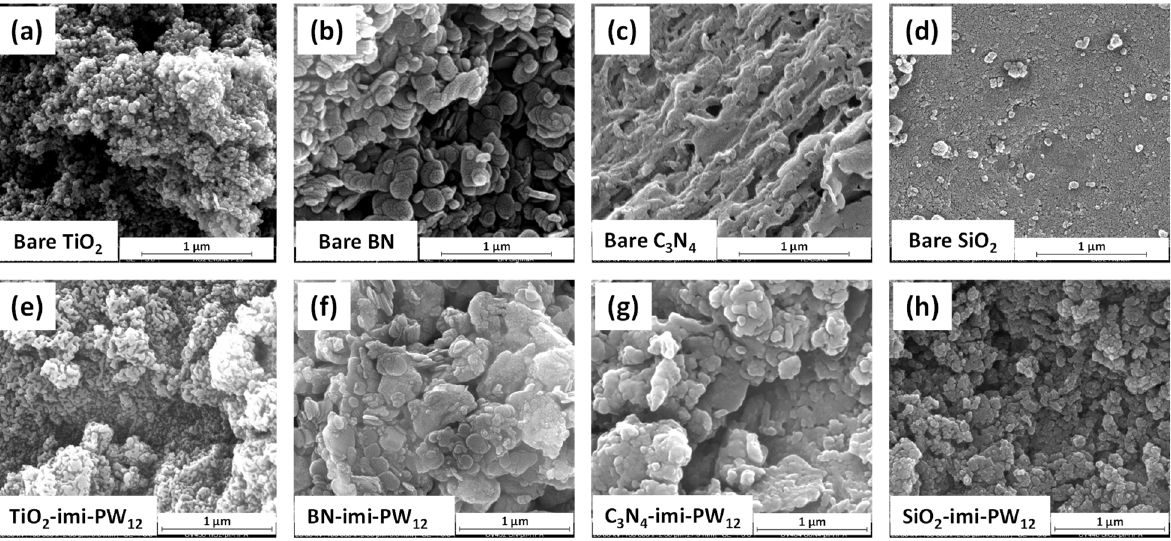
Figure 2. SEM picture of bare TiO 2 , BN, C 3 N 4 , and SiO 2 supports and TiO 2 − imi − PW 12 , BN − imi − PW 12 , C 3 N 4 − imi − PW 12 , and SiO 2 − imi − PW 12 samples. BN − imi − PW 12 , C 3 N 4 − imi − PW 12 , and SiO 2 − imi − PW 12